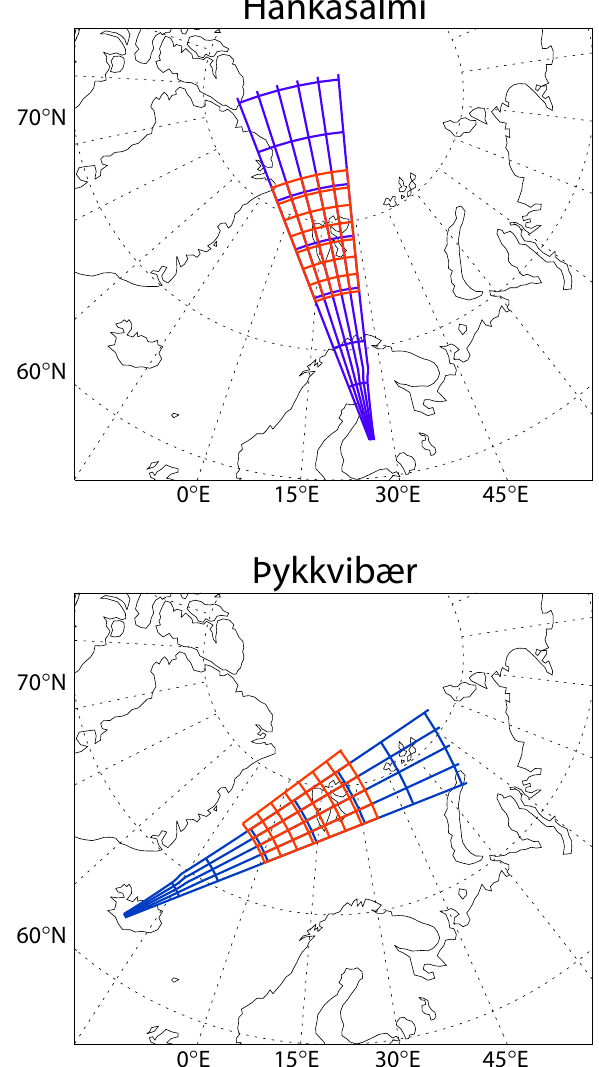
Fig. 3. A map illustrating the beam patterns employed by the CUT- LASS radars during this experiment. The two fields of view of the radars are made possible by operating each radar in its stereo mode. Along the radar beams the range is marked every 10 range